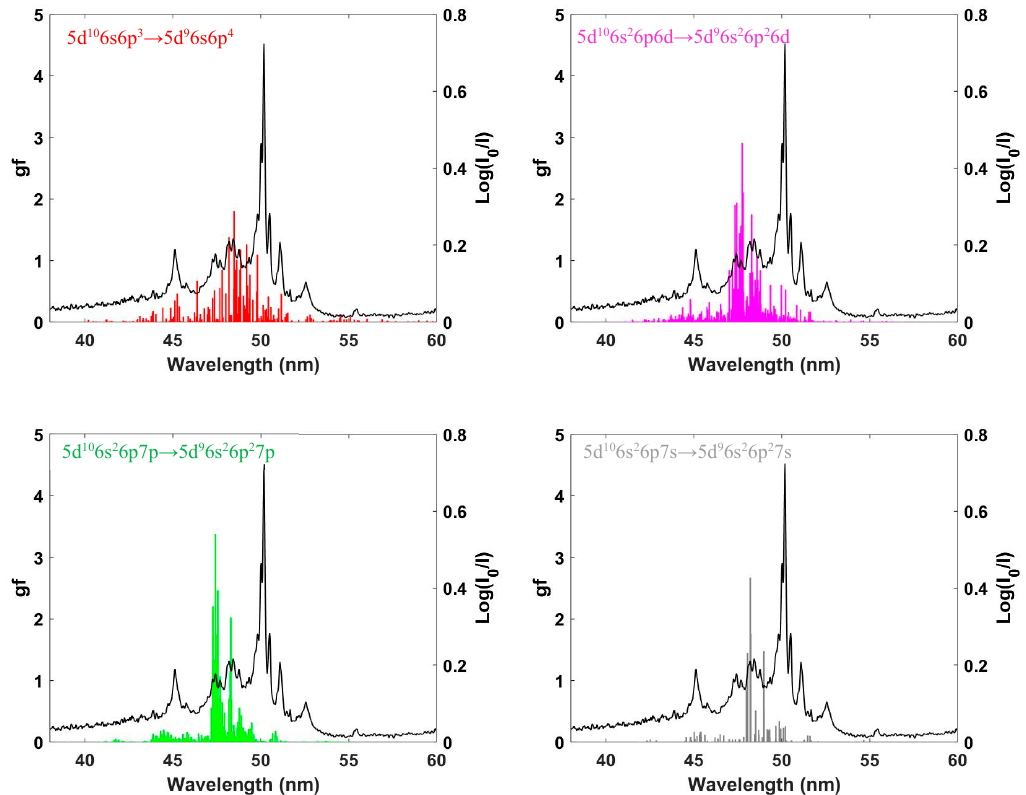
Figure 2. Calculated gf values for 5d–6p transitions from low-lying, excited configurations of Bi + compared to the observed spectrum. From top to bottom and from left to right: 5d 10 6s6p 3 → 5d 9 6s6p 4 , 5d 10 6s 2 6p6d → 5d 9 6s 2 6p 2 6d, 5d 10 6s 2 6p7p → 5d 9 6s 2 6p 2 7p and 5d 10 6s 2 6p7s → 5d 9 6s 2 6p 2 7s.